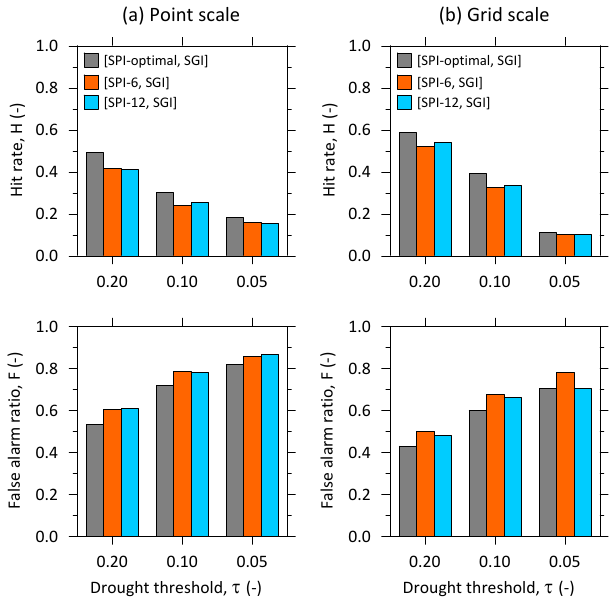
Figure 8. The hit rate ( H ) and the false alarm ratio ( F ) averaged over all investigated (a) wells and (b) grid cells to detect SGI-based groundwater droughts using the SPI with the optimal accumulation and 6 and 12 months of uniform accumulation periods for vary- ing levels of threshold value τ (0.2, 0.1, and 0.05) used to identify drought